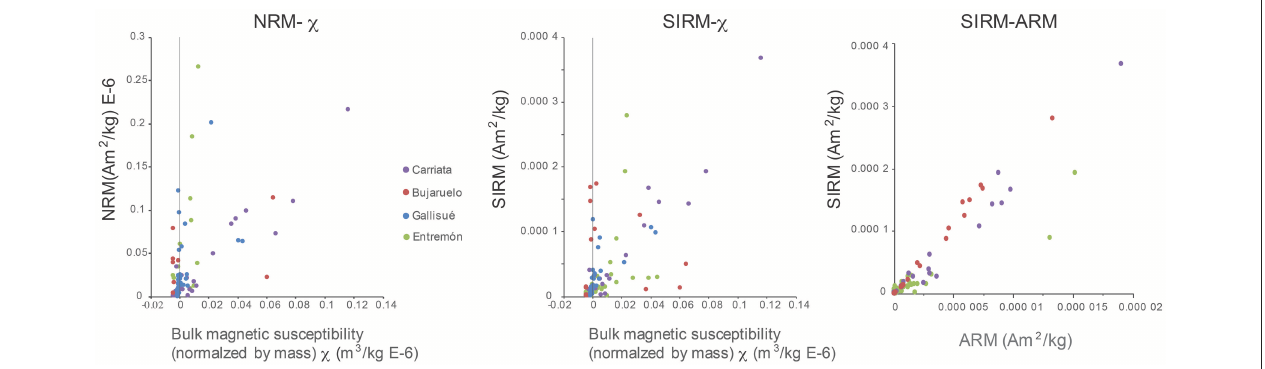
FIGURE 11 | Biplot diagrams with magnetic values of NRM, bulk susceptibility, SIRM (at 0.5T), and ARM, normalized by